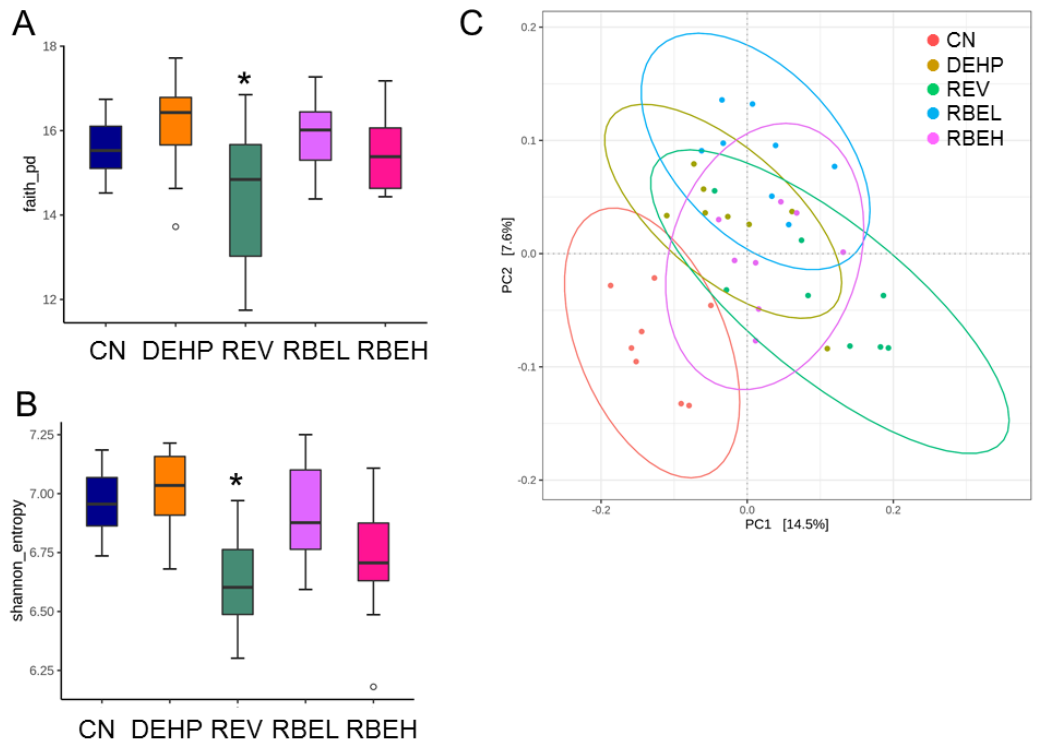
Figure 7. Bacterial α -diversity for gut microbial communities among five groups in ( A ) Faith’s phylogenetic diversity (PD) index and ( B ) the Shannon index; ht panel). The outliers are shown as dots. * p < 0.05. ( C ) Bacterial β -diversity analysis using the principal coordinate analysis (PCoA) based on unweighted UniFrac distance of the OTUs in five groups; each dot represents the microbiota of a single sample, and the color of the dot reflects the metadata for that sample. N = 8/group.